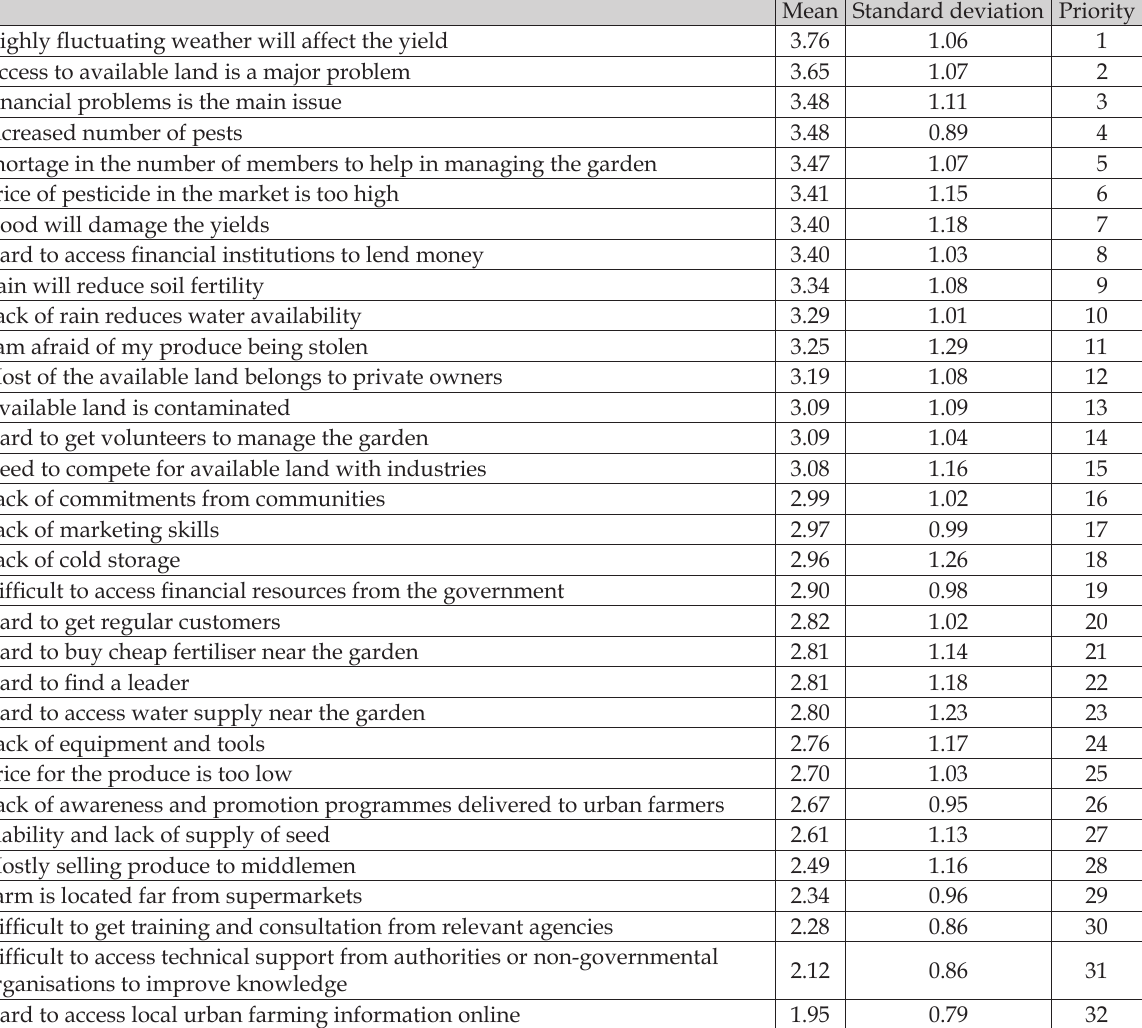
Table 3. Prioritising challenges facing urban gardens.